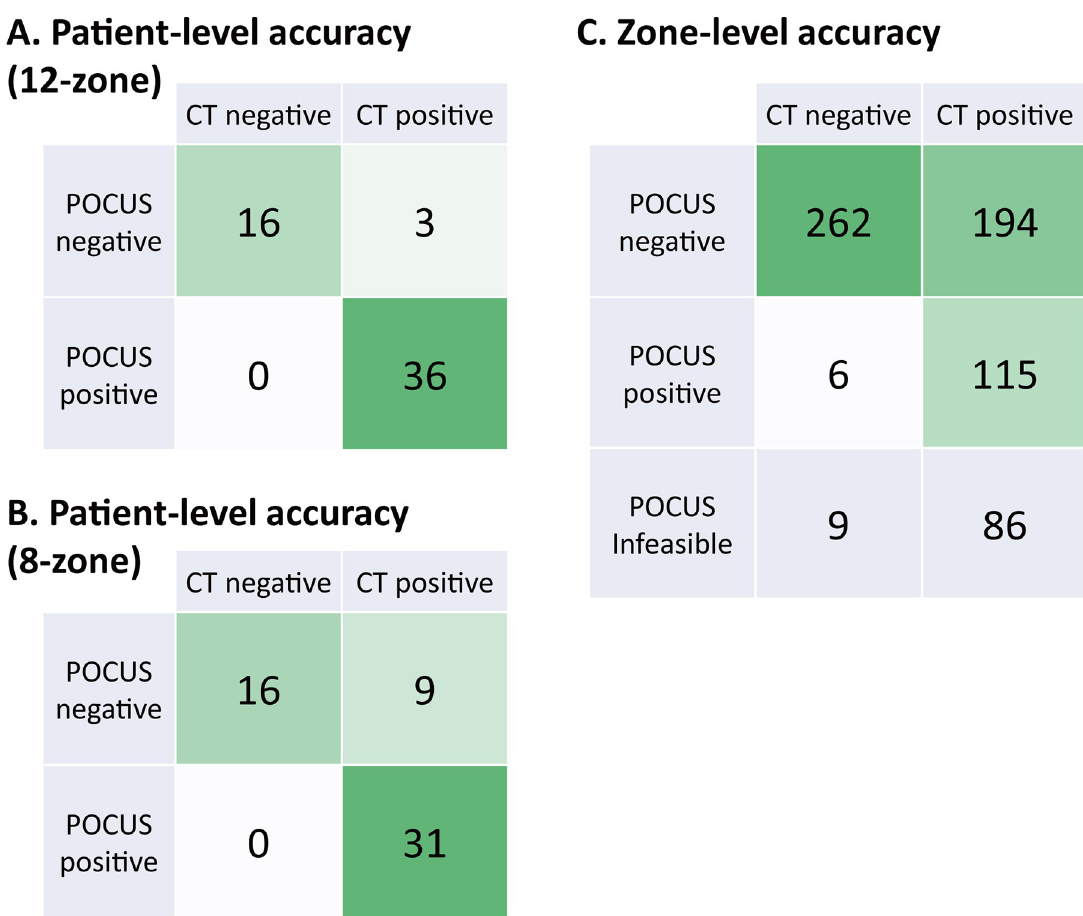
Fig 5. Accuracy of AI-POCUS versus CT. Each panel is a confusion matrix showing the concordance between the AI-POCUS results and CT-validated pneumonia diagnosis.